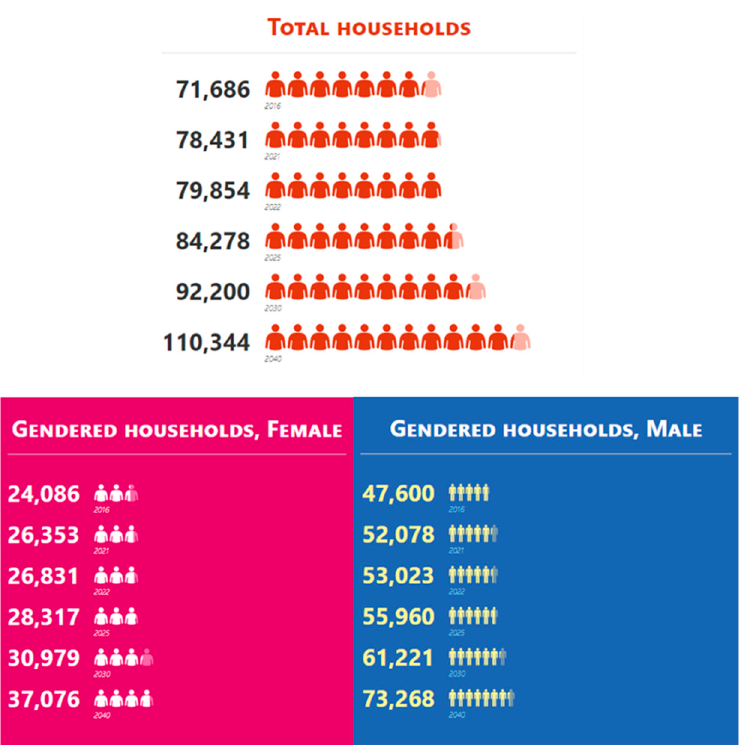
Figure 3. Total households and gendered households, BAU scenario. Source: Authors.